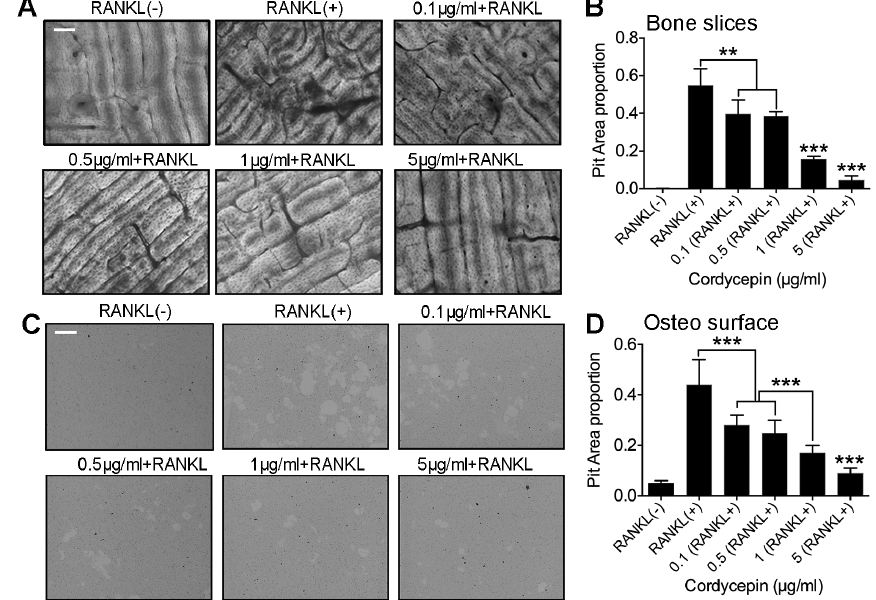
Figure 4. Cordycepin reduces osteoclastic bone resorption activity in a dose-dependent way. ( A ) Representative images of primary BMMs cultured on bovine slices treated with RANKL (50 ng/mL) and M-CSF (50 ng/mL) for five days with different concentrations of cordycepin treatment (0 µ g/mL, 0.1 µ g/mL, 0.5 µ g/mL, 1 µ g/mL, and 5 µ g/mL). ( B ) Quantification of RANKL induced osteoclastic bone resorption in the bone slices group. ( C ) Representative images of Osteoassay surface 96-well plate after removal of osteoclasts. ( D ) Quantification of RANKL induced osteoclastic bone resorption in the osteo surface group. Scale bar represents 400 μ m. Data in the figures represent average ± SD. ** p < 0.01, *** p < 0.001 based on one way ANOVA.